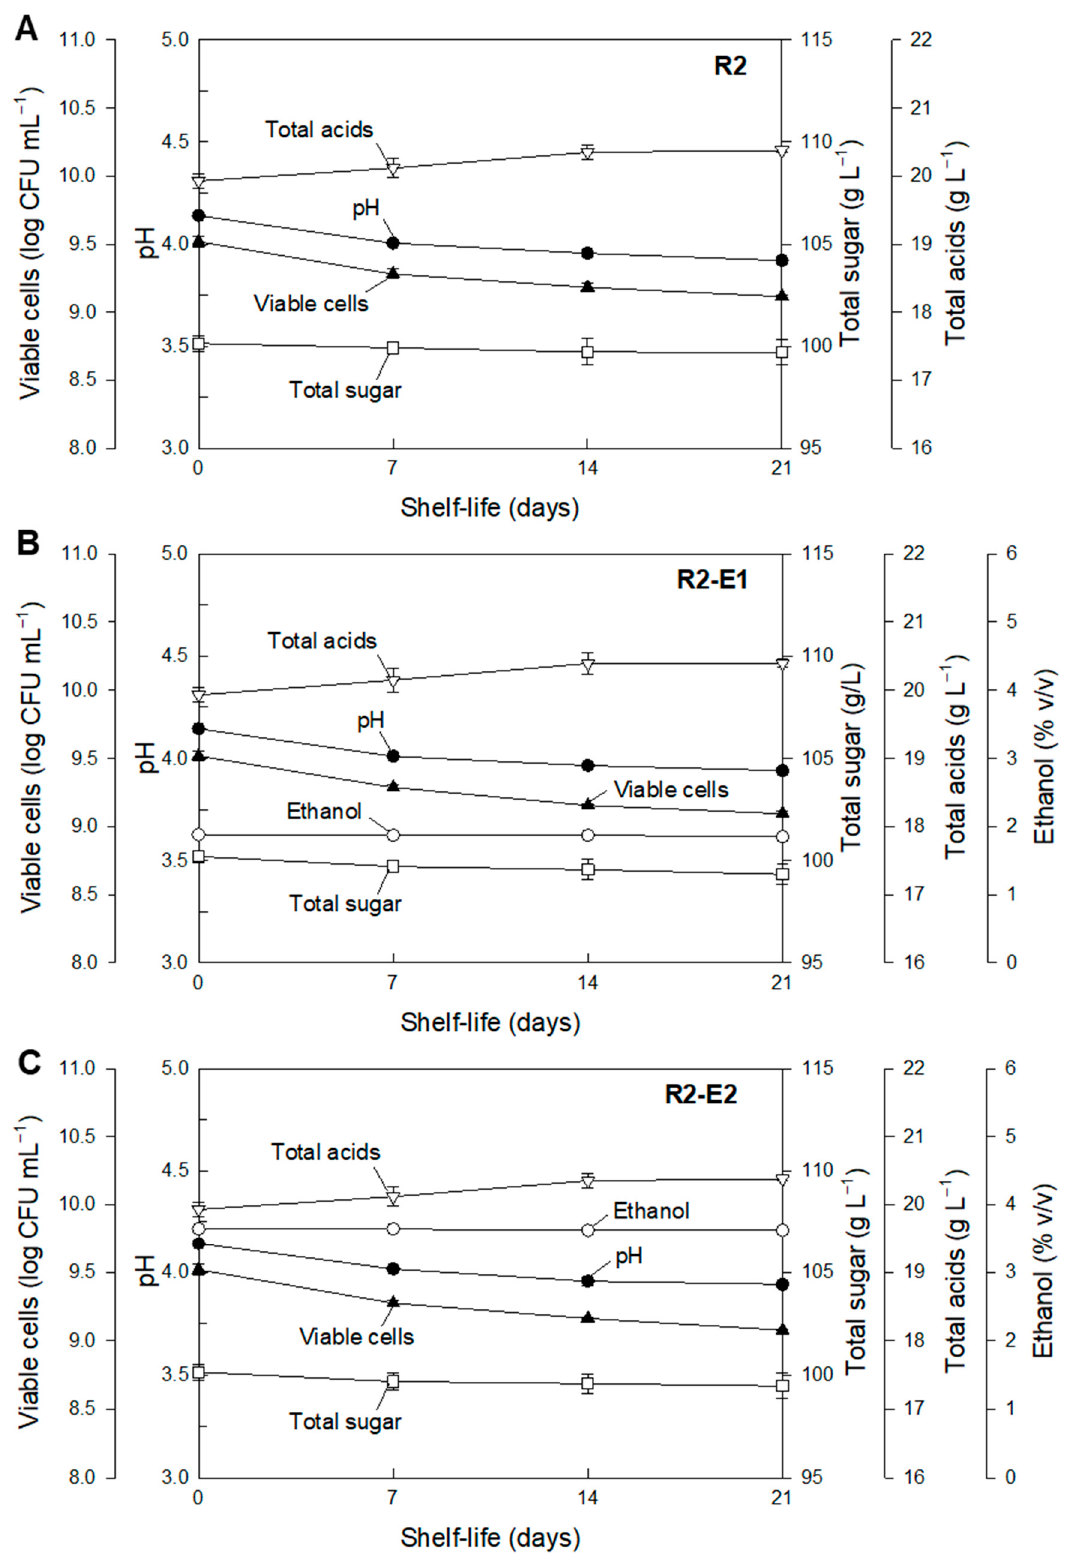
Figure 3. Effects of supplemental ethanol in R2-E1 and R2-E2, on profiles of viable cells, pH, total sugar, and total acids during refrigerated (4 °C) storage: ( A ) R2, fermented whole pineapple juice Recipe 2 (no supplemental ethanol) used as control; ( B ) R2-E1, fermented whole pineapple juice Recipe 2 with 2% v / v supplemental ethanol; ( C ) R2-E2, fermented whole pineapple juice Recipe 2 with 4% v / v supplemental ethanol.